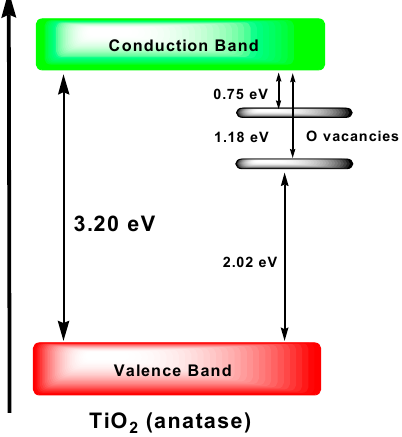
Figure 18. Proposed band structure model for the anatase TiO 2 with oxygen vacancies. Table 3. Physicochemical properties of the standard reference TiO 2 photocatalysts (JRC-TiO-2, -3, -4, and -5) supplied by the catalysis Society of Japan **.